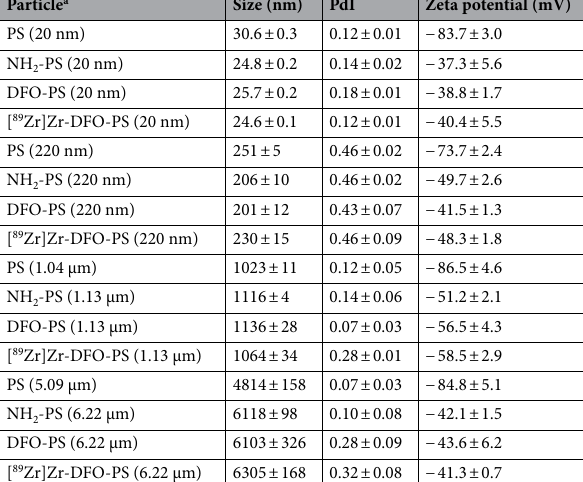
administration of the radiolabeled material. At 6, 12, 24, and 48 h post injection, mice (n = 5) were euthanized via asphyxiation using CO 2 (g), and selected tissues were collected and placed into pre-weighed tubes. The mass of each organ was determined, and each sample was then counted using a Wizard 2 automatic gamma counter. Four aliquots (5 µL) were weighed and counted as internal standards for each radiolabeled construct. The total injected dose was found as the mass injected dose × internal standard average counts/g. The percent injected dose (%ID) was determined as the counts for the tissue × 100/total injected dose. The %ID/g was calculated as the %ID/tissue mass in g. PET imaging. PET imaging was carried out on an Inveon PET/CT scanner (Siemens) or a microPET Focus 120 scanner (Concorde Microsystems). The mice were fasted for 18 h before the administration of [ 89 Zr]Zr-